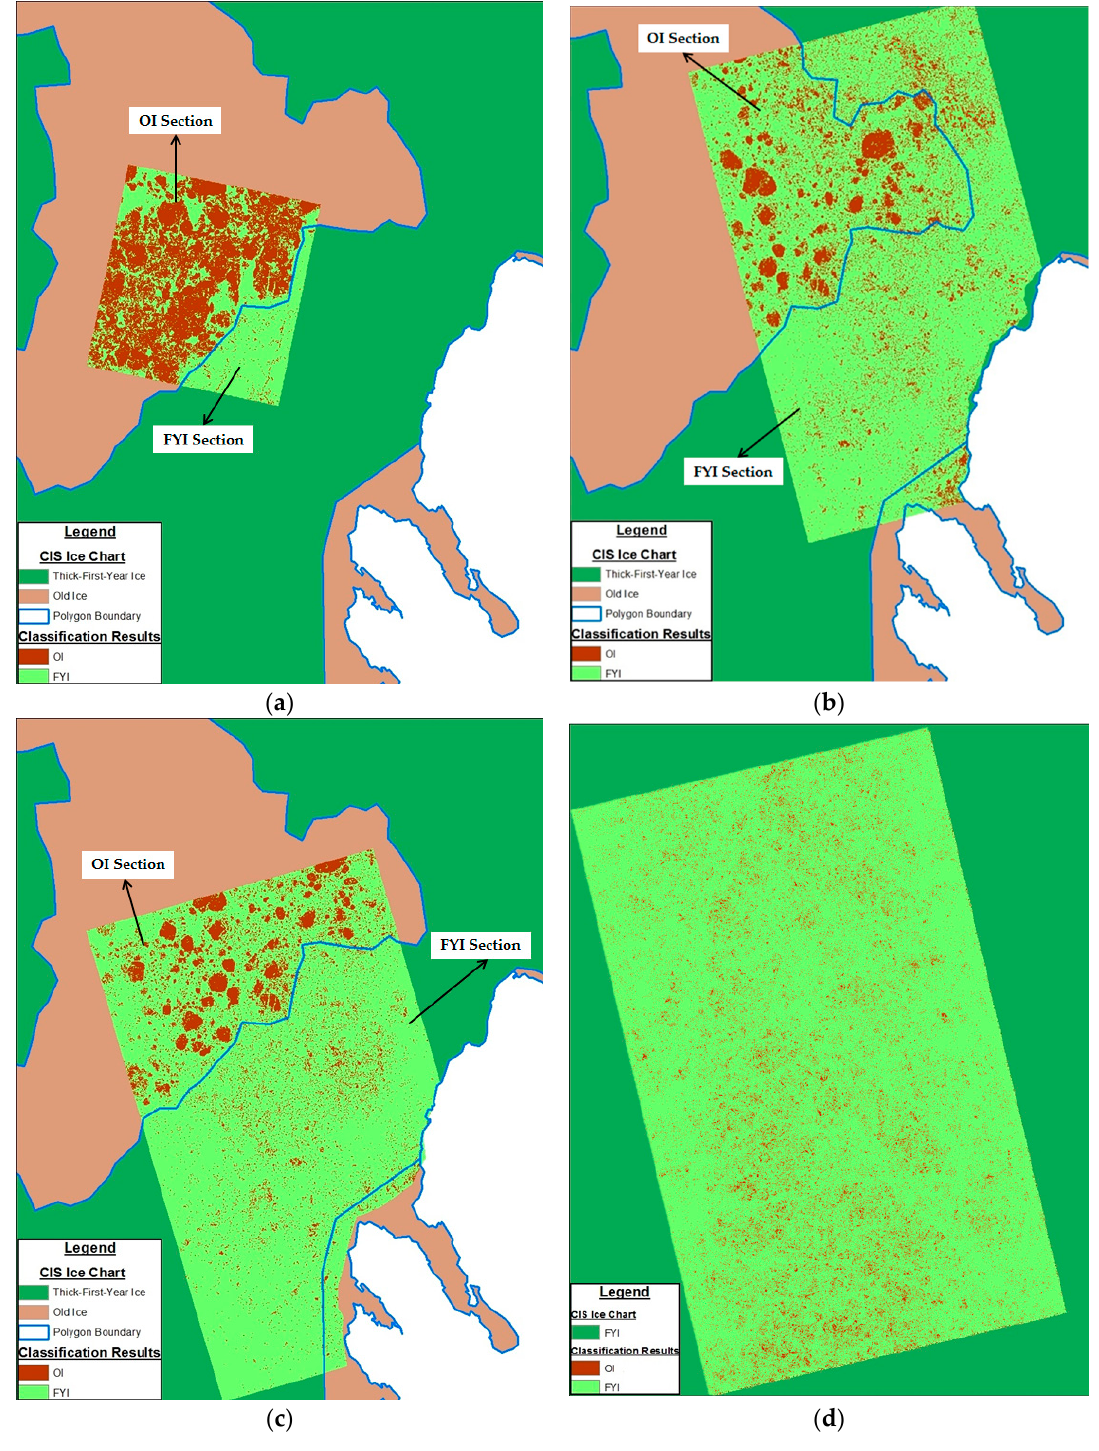
Figure 6. Overlay of the classification results of ( a ) RADARSAT-2 image, ( b ) 5 April ALOS-2 image and ( c ) 28 April ALOS-2 image over the sea ice chart valid for 27 April 2015. ( d ) Overlay of the classification results of Hudson Bay ALOS-2 image over the sea ice chart valid for 20 April 2015. Charts are according to the predominant ice type WMO color code.